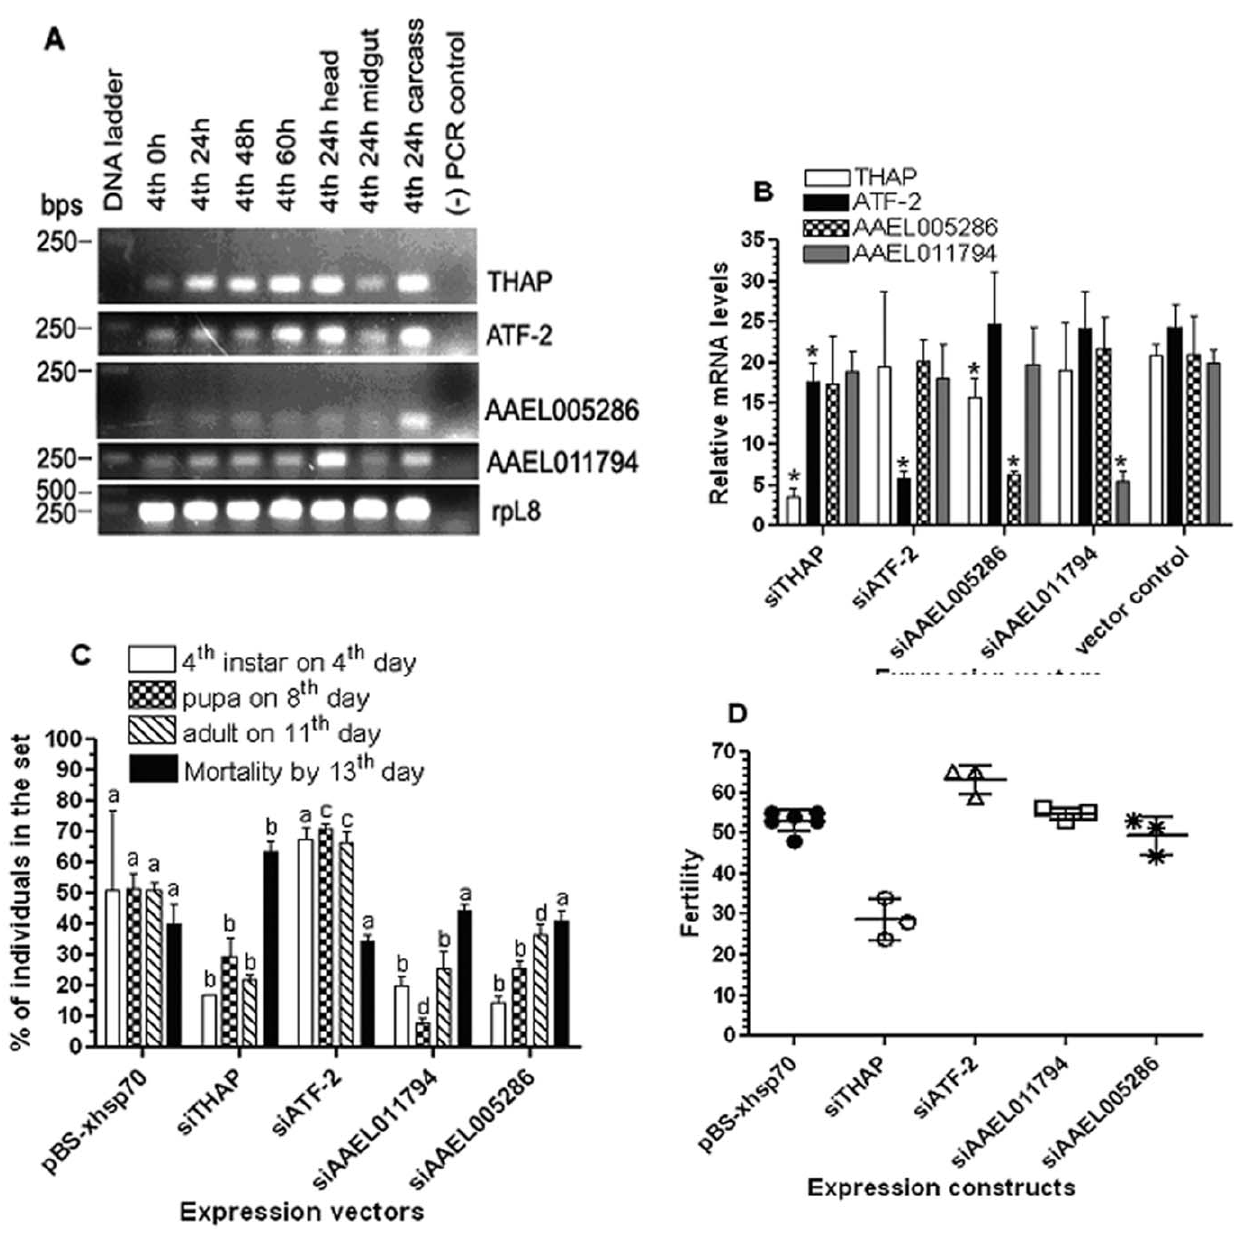
Figure 3. Effects of expression knockdown of the transcription factors (Table 1, 24 h) on the progression of development, mortality, and female fertility. The siRNA vector is driven by the Drosophila hsp70 short promoter. Thirty larvae were synchronized on Day 1 2 nd instar, heat shock at 37 u C started on Day 1 of 2 nd instar through pupal stage and adults were returned to 26 u C. ( A ) Temporal/spatial transcription profiles of the transcription factors in 4 th instar larvae via semi-quantitative RT-PCR (30 cycles). ( B ) RNA sample of pooled 24 h 4 th instar larval midguts (10 larvae/sample) was taken from randomly selected larvae in each respective group (triplicate batches). Relative quantity of mRNA (vs. rpL8 ) was determined via RT-qPCR analysis. Mean 6 standard deviation (N=3). * Indicate significantly different ( p , 0.05, paired t-test) from the vector control. ( C ) Developmental progress and mortality was recorded daily. The same letter as the vector control above the bars represents that the mean values did not differ from the control significantly in paired t-test ( p . 0.05). Different letters above each construct represent that the mean values were significantly different between constructs ( p , 0.05). ( D ) Female fertility was measured as producing viable 2 nd instar larvae per blood-fed female (after the 1 st bloodmeal) in 3–6 batches ( . 5 female/batch) of each mating group. Each group in panel ‘‘A’’ had $ 5 surviving pairs per batch. Mean and standard deviation are shown (N=3 2 6).